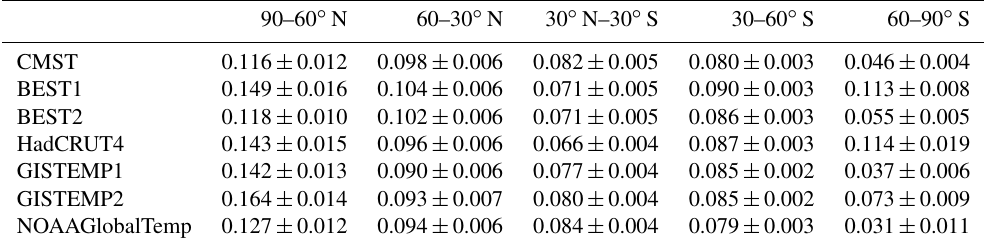
Table 3. Regional ST trends for different latitude zones from 1900 to 2017 (degrees Celsius per